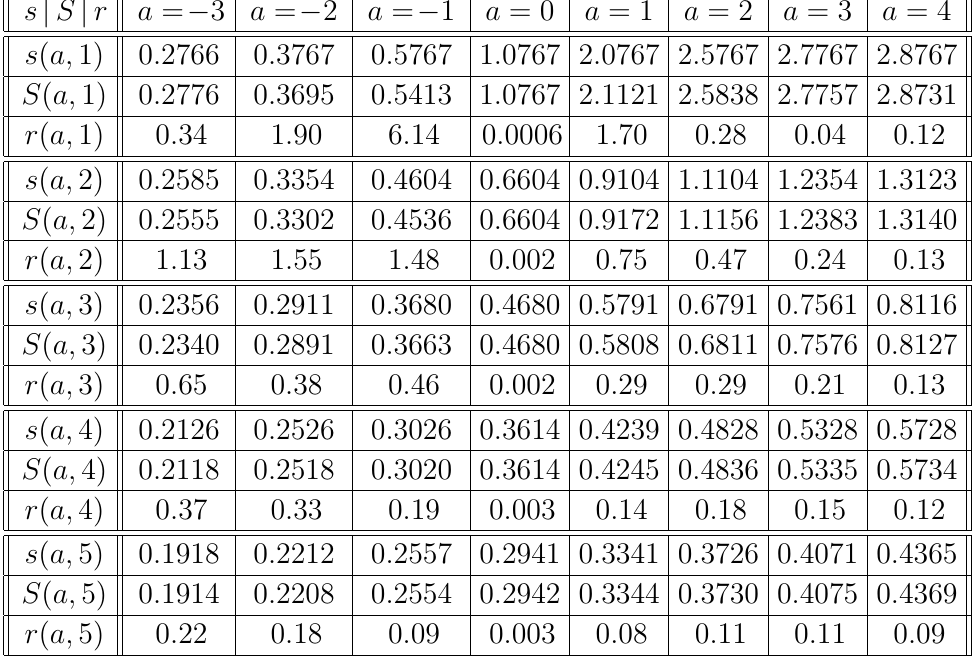
Table 2: Some approximate values of the sums s ( a, b, 10 5 ) , S ( a, b ) and the relative quantification accuracies r ( a, b ) of the sums s ( a, b, 10 5 ) for some values of a and b